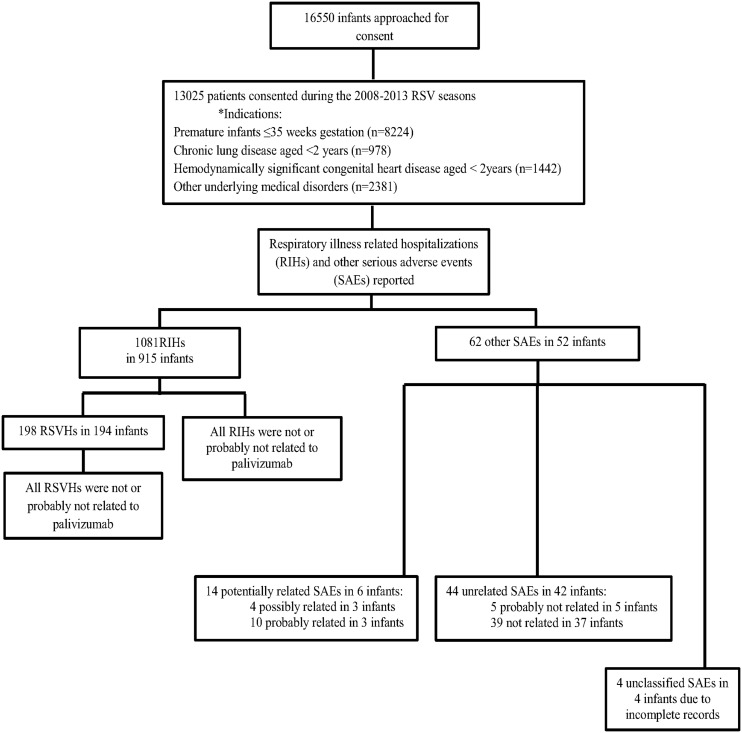
Flow diagram of recruited subjects and related serious adverse events.*Note: The premature group refers to preterm infants only; the “Other” category of infants with serious underlying medical disorders also comprises premature infants.